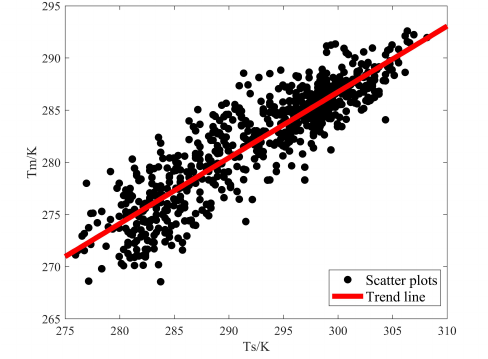
Figure 2. Scatter plots and trend line of T m and T s